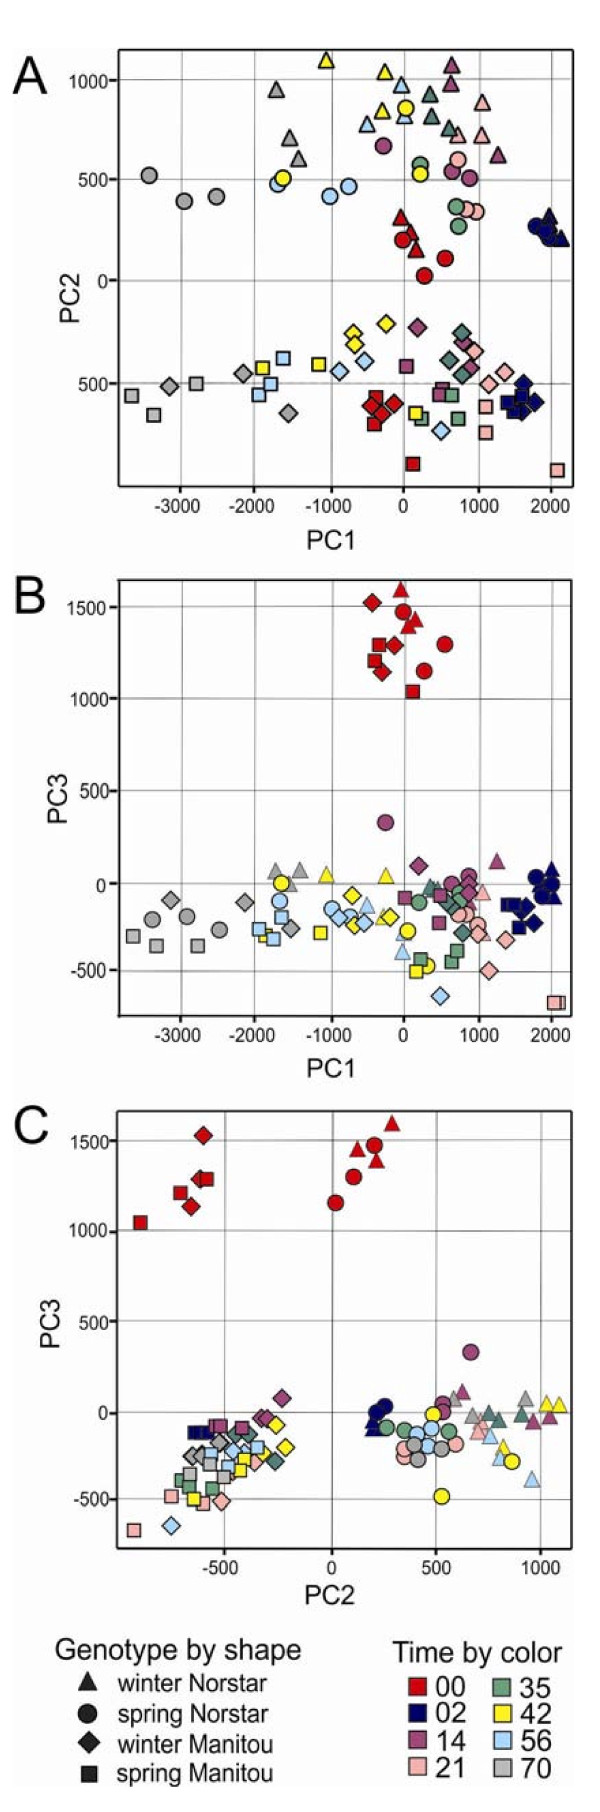
Principal component analyses. PC1 (Principal Component 1) separated the samples by the duration of cold-treatment; PC2 separated the samples by genotype and PC3 separated the samples by treatment (cold treated versus untreated). Symbols with the same shape and color represent biological replicates; the numbers on the axes of the graphs refers to the eigenvalues for each component.